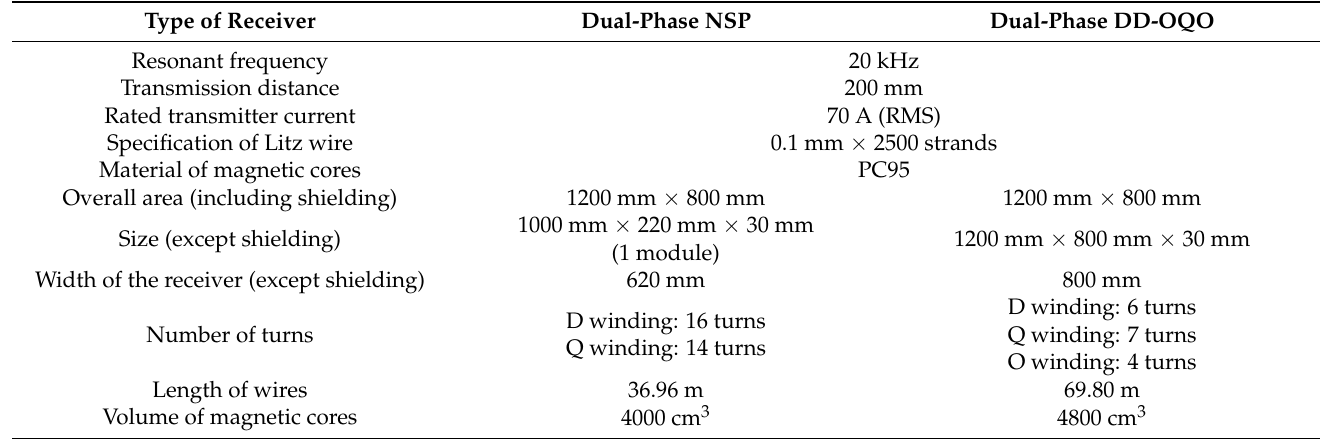
Table 2. Design indexes and the information of the design results.